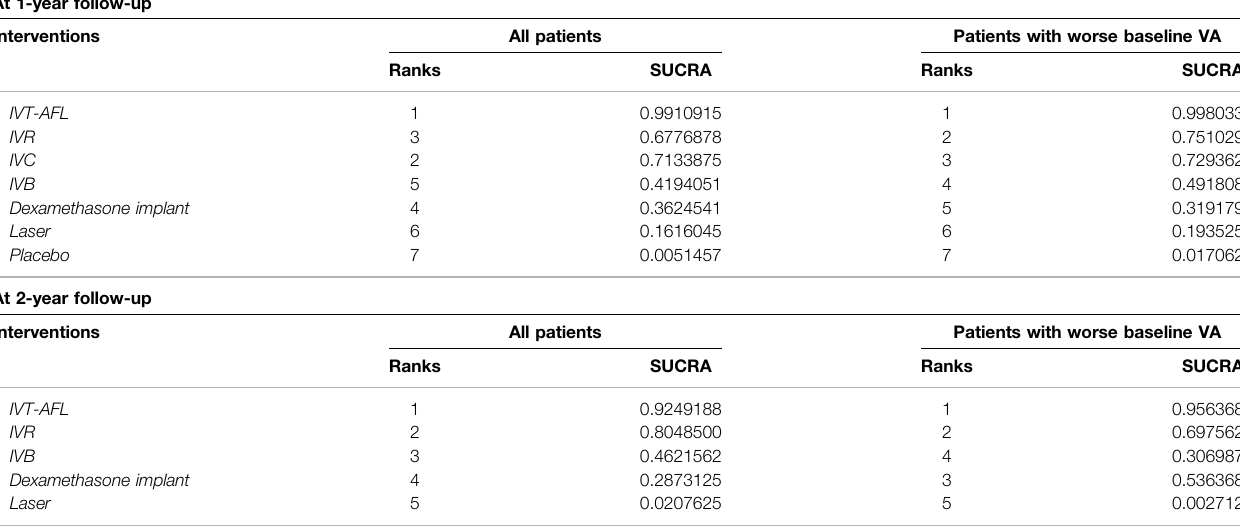
TABLE 2 | Ranking probabilities for all interventions for BCVA (ETDRS letters) mean change from baseline. At 1-year follow-up Interventions All